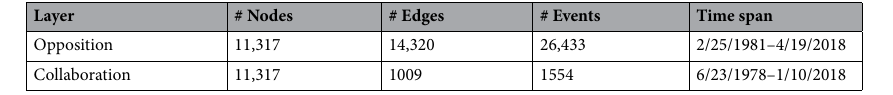
Table 1. Properties of the two-layer temporal network of patent oppositions and collaborations.